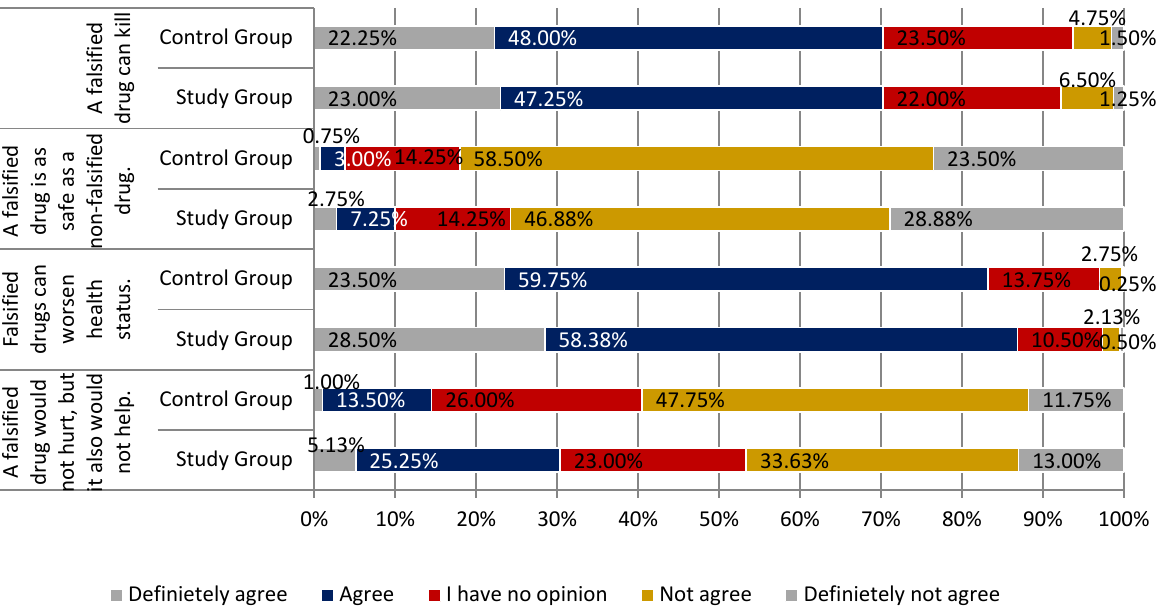
Study Group Control Group Study Group Control Group Study Group Control Group Study Group Control Group Study Group Control Group Study Group